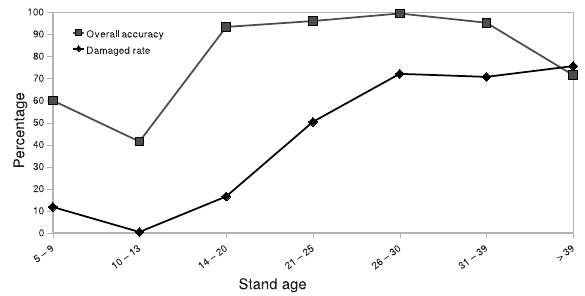
Figure 9: Classification accuracy and damaged pixel rate with respect to age